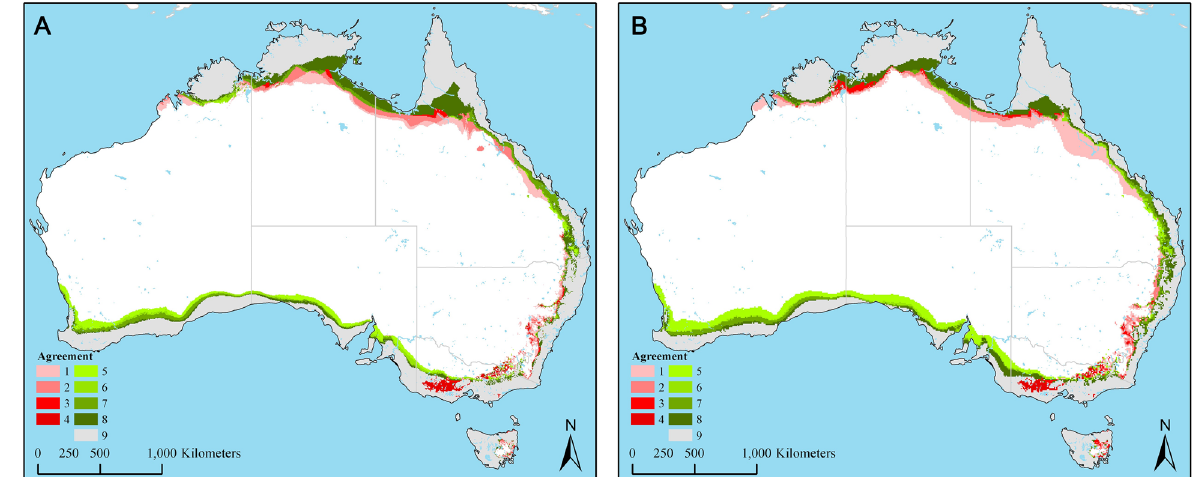
Figure 3. ( A ) Agreement among the general circulation models (GCMs) in predicted future distribution of Ixodes holocyclus under the low-emissions representative concentration pathway (RCP) 4.5 scenario. Gray indicates areas under stable suitable conditions. Lighter to darker shades of red indicate areas in which one and progressively more GCMs predicted gains in suitability for I. holocyclus distribution under RCP 4.5 scenario. Lighter to darker shades of green indicate areas in which one and progressively more GCMs predicted loss of territory for I. holocyclus compared to present day distribution. ( B ) Agreement among the general circulation models (GCMs) in predicted future distribution of Ixodes holocyclus under the high-emissions representative concentration pathway (RCP) 8.5 scenario. Gray indicates areas under stable suitable conditions. Lighter to darker shades of red indicate areas in which one and progressively more GCMs predicted gains in suitability for I. holocyclus distribution under RCP 8.5 scenario. Lighter to darker shades of green indicate areas in which one and progressively more GCMs predicted loss of territory for I. holocyclus compared to present day distribution.